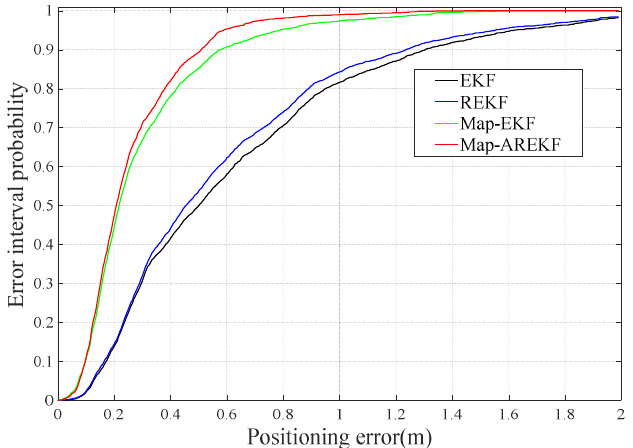
Figure 22. Probability statistics of algorithm localization error for Experiment 2.